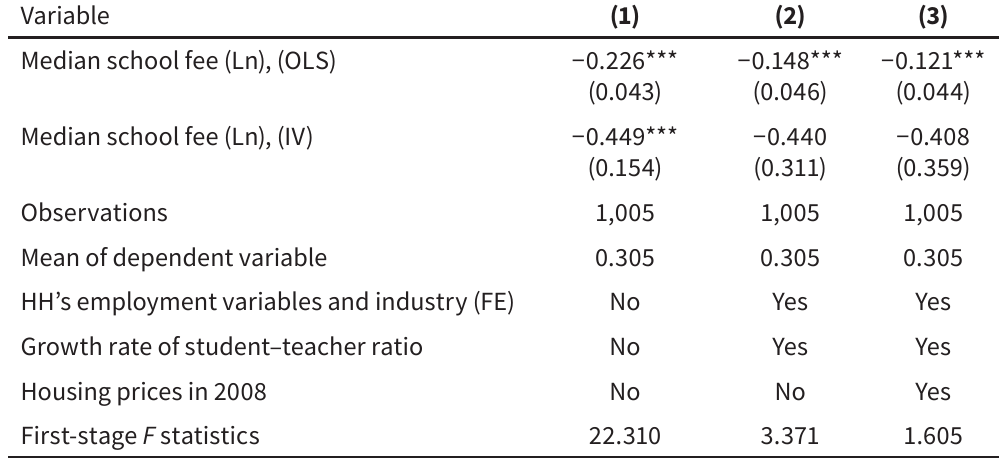
Median school fees and child migration during the economic crisis, China 2009 Variable